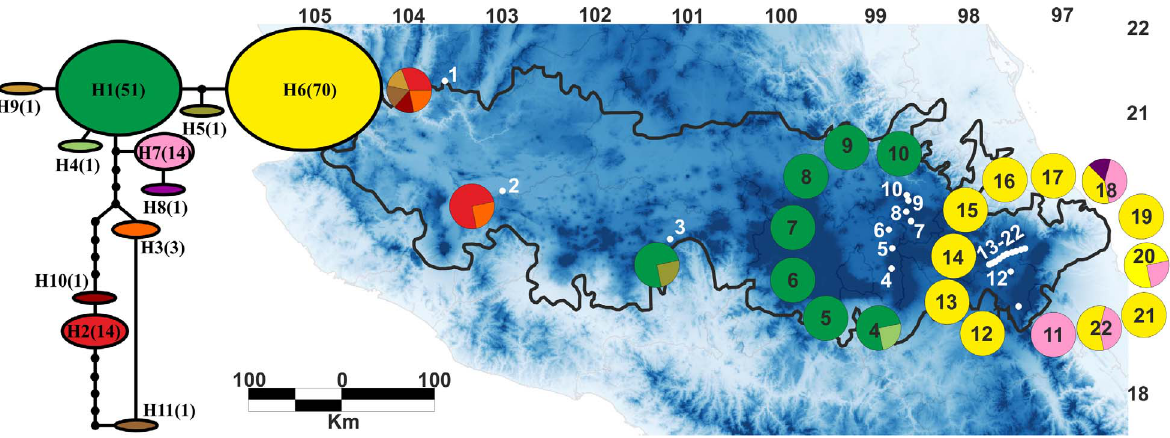
Figure 2. Statistical parsimony network and map of geographical distribution of 11 cpDNA haplotypes found in Nolinaparviflora . H1-H11: sampled haplotypes. Solid black circles: hypothetical haplotypes. Numbers in brackets indicate individuals. Pie charts represent chloroplast haplotypes for each sampling locality. Population numbers correspond to those in Table 1.